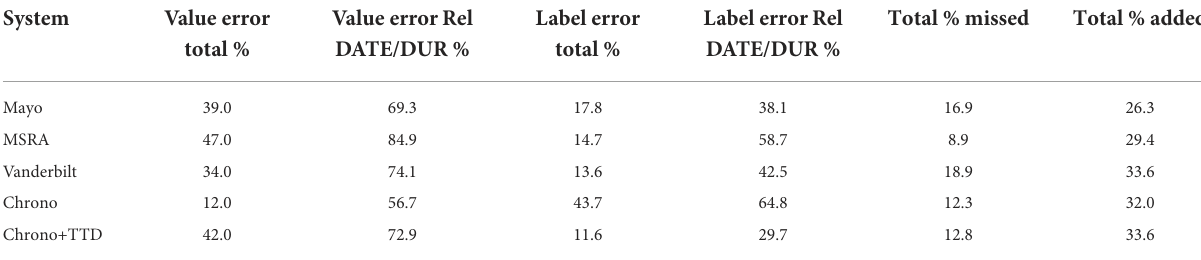
TABLE 2 Percent of errors for value, label, missed, and added error categories out of all errors for the top i2b2 systems, Chrono, and Chrono plus the temporal disambiguation module